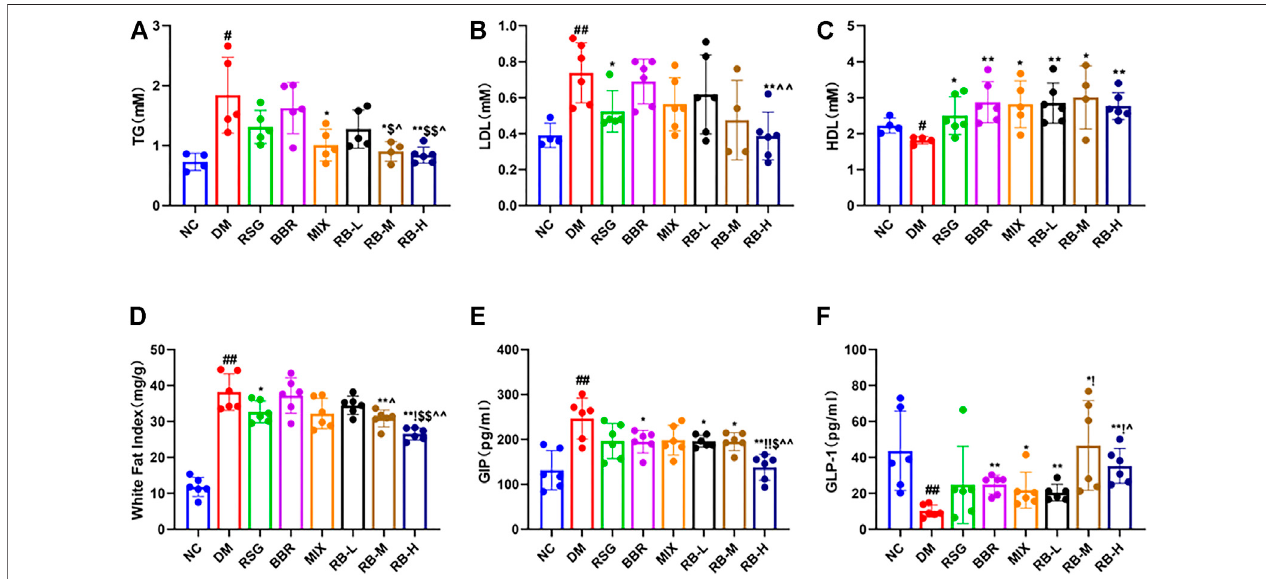
FIGURE 3 | RB ameliorated lipid metabolism in diabetic KKAy mice. (A) Triglyceride (TG); (B) Low-density lipoprotein (LDL); (C) High-density lipoprotein (HDL), inconsistent numbers of mice detected in A,B, and C plots due to insuf fi cient serum samples; (D) White fat index (WFI); (E) Gastric inhibitory polypeptide (GIP); (F) Glucagon-likepeptide-1(GLP-1).Dataareexpressedasthemean±SD. # p < 0.05, ## p < 0.01,vs.NCgroup;* p < 0.05,** p < 0.01,vs.DMcontrolgroup; $ p < 0.05, $$ p < 0.01, vs. RSG group; ^ p < 0.05, ^^ p < 0.01, vs. BBR group; ! p < 0.05, !! p < 0.01, vs. MIX